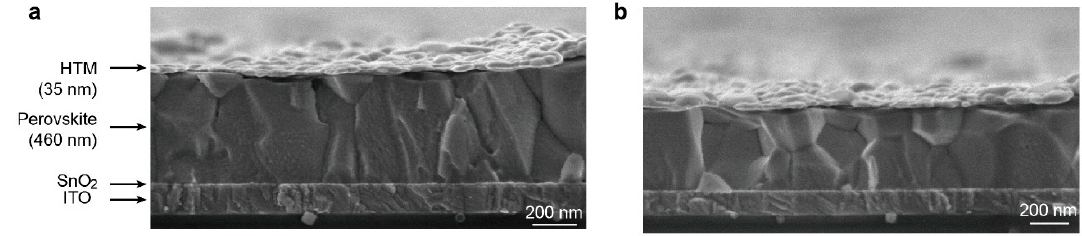
Figure 3. ( a ) A cross-sectional SEM image of the CZTPA-1 PSC. The scale bar is 200 nm. ( b ) A cross-sectional SEM image of the CZTPA-2 PSC. The scale bar is 200 nm.